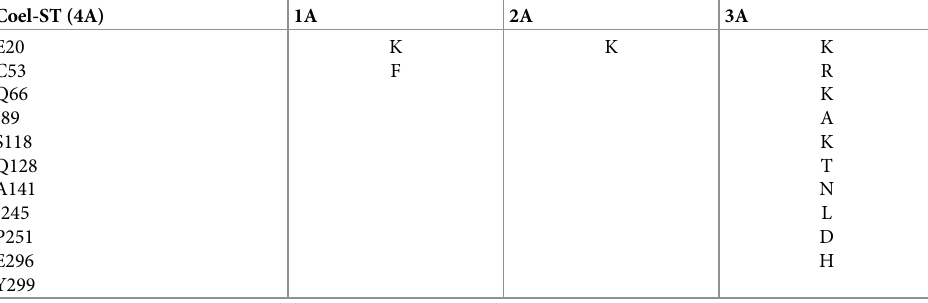
Table 2. Amino acid differences in the four different translated isoforms of the 12.16 assembled transcript.